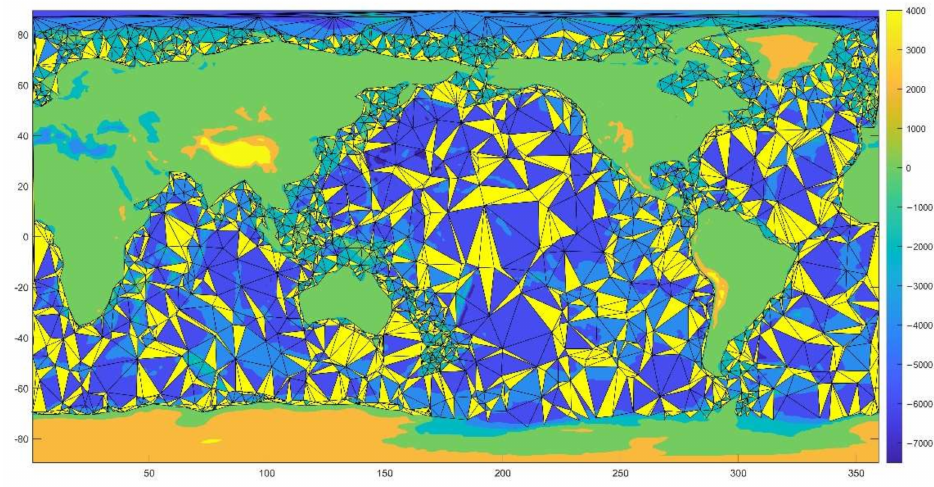
Figure 7. Global ocean unstructured grid formed after Delaunay